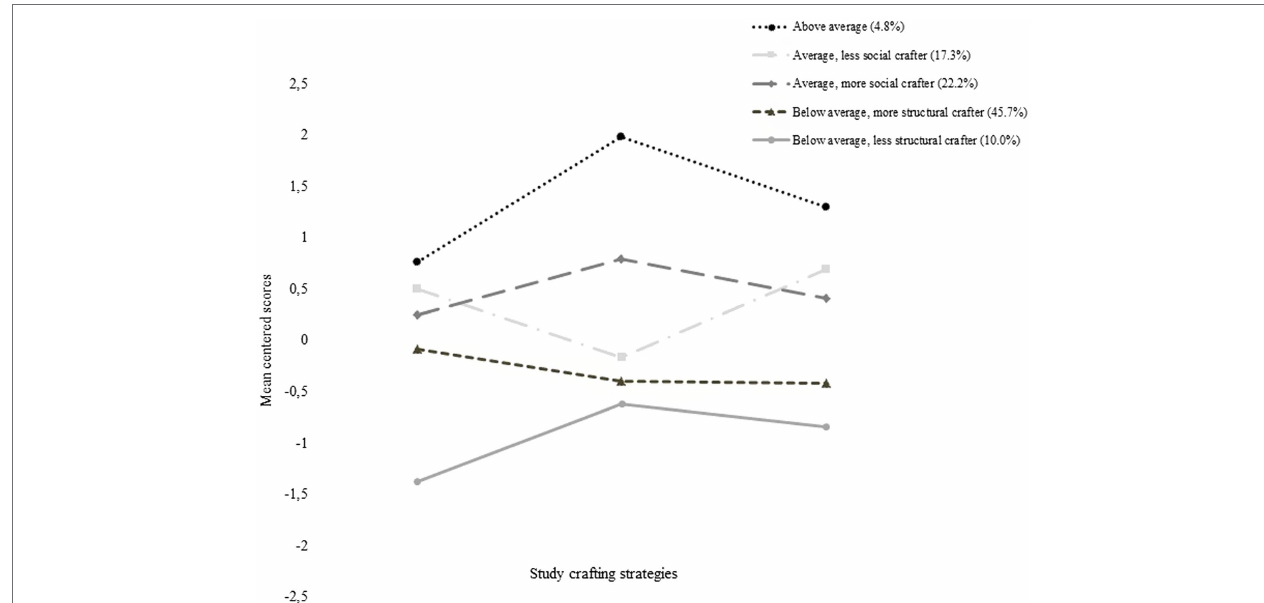
FIGURE 1 | Mean centred scores on study crafting strategies for the five latent